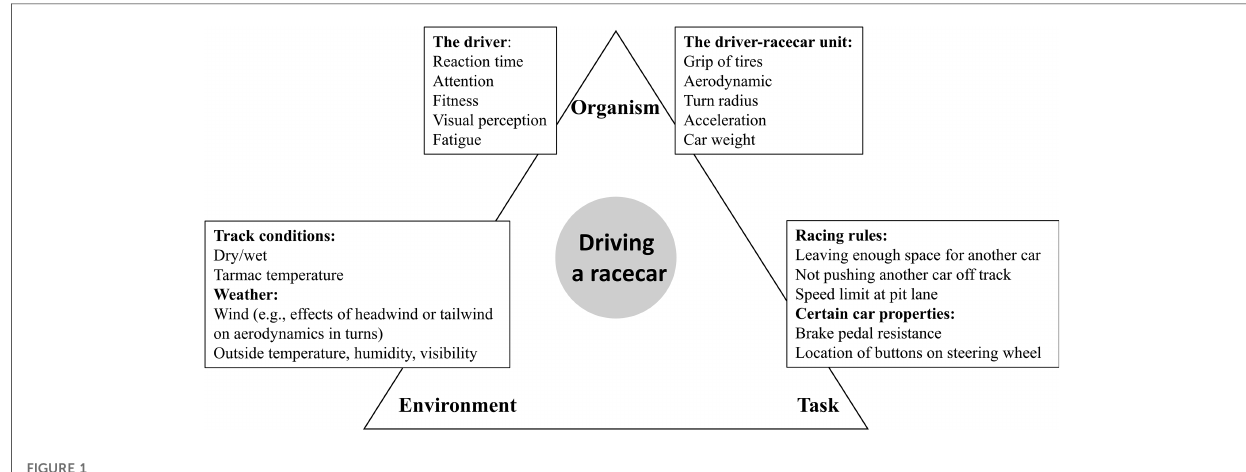
FIGURE 1 The constraints in racecar